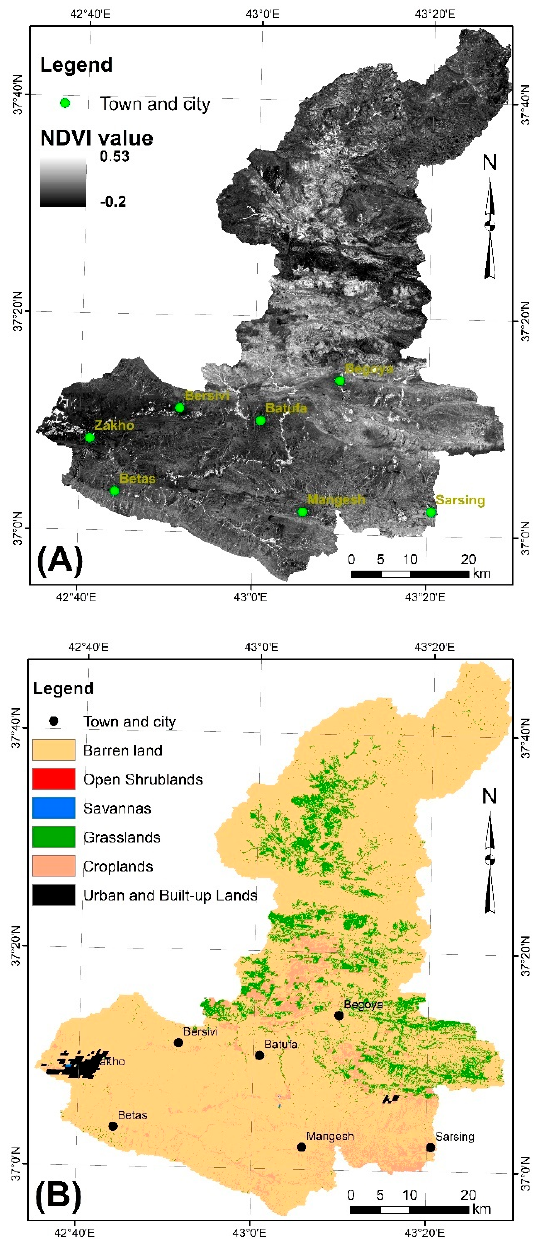
Figure 7. Maps showing ( A ) MODIS land cover (MOD12Q1) in 2019, and ( B ) the NDVI extracted from Landsat OLI, acquired on 26 August 2019.